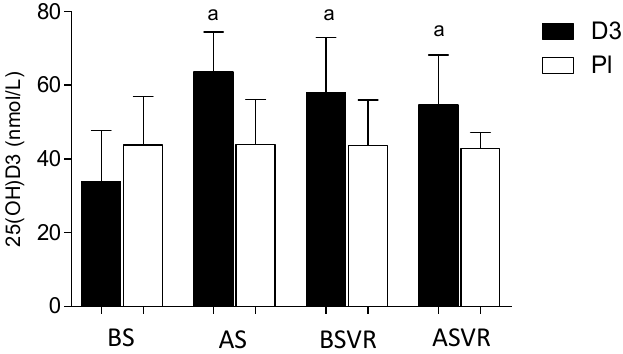
Figure 2. The concentration of 25(OH)D3 in the serum, after five weeks of supplementation, was significantly increased. Columns, mean; bars SD; and a, p < 0.05, significantly different compared with BS. BS—before supplementation, AS—5 weeks after supplementation, BSVR—4 weeks after surgery, and ASVR—10 weeks after supervised rehabilitation.